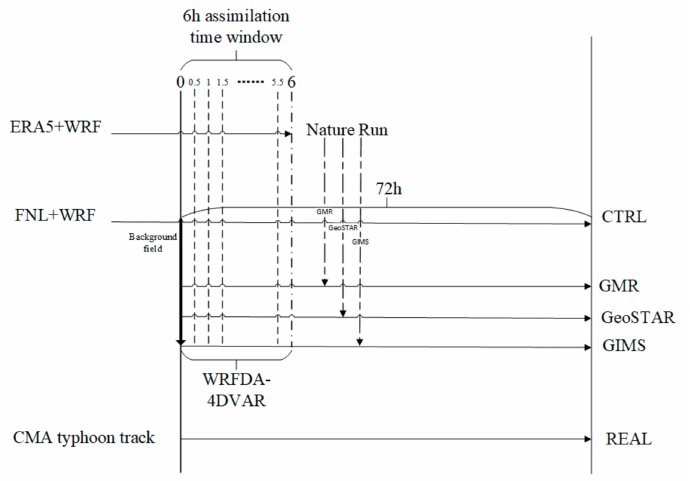
Figure 10. Sequence diagram of CTRL, REAL, DA-GMR, DA-GeoSTAR, and DA-GIMS experiments. The WRFDA-4Dvar assimilation experimental parameter settings of Typhoons